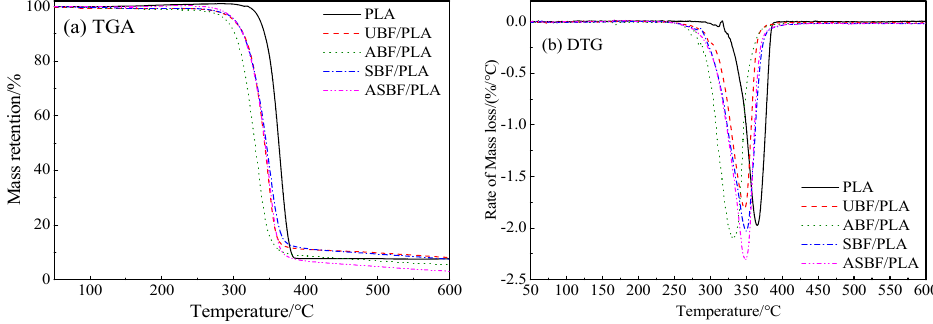
Figure 9. TGA curves of PLA/BF composites with different modified BF (Heating rate 10 °C/min).